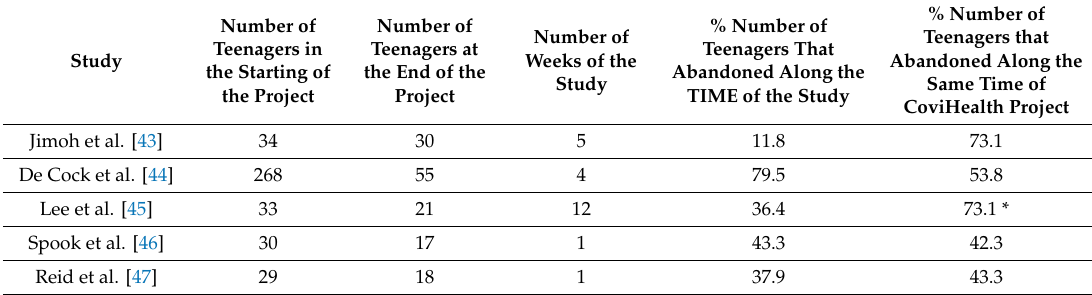
Table 8. Comparison of other studies with the CoviHealth